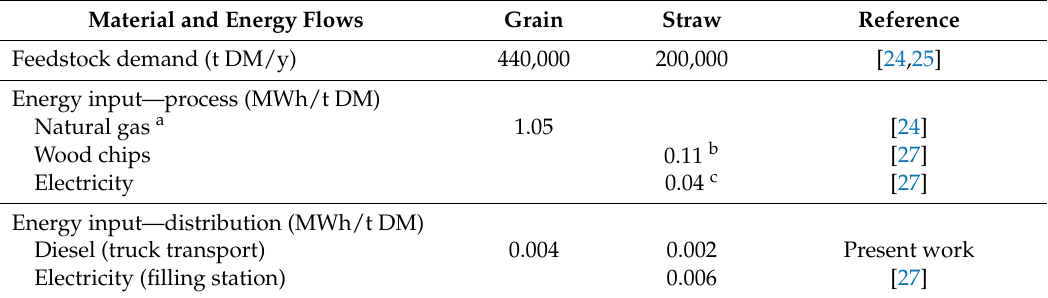
Table 2. Material and energy flows in the production of ethanol from wheat grain and